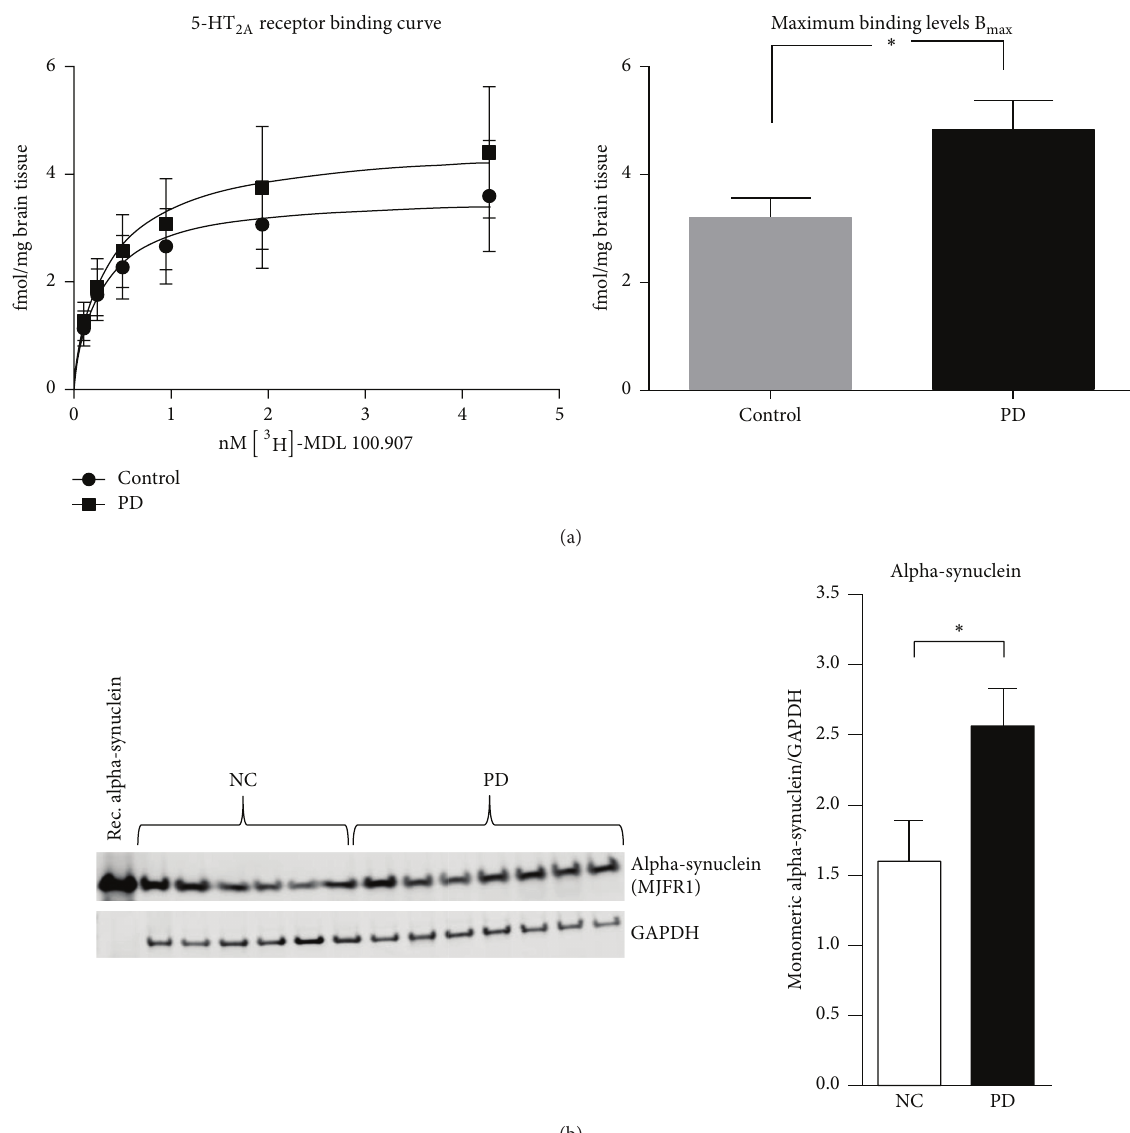
Figure 1: Receptor binding analysis and alpha-synuclein levels in postmortem prefrontal cortex of Parkinson’s disease (PD) patients. (a) Binding assays with [ 3 H] MDL100.907 comparing membrane suspensions from postmortem prefrontal cortex of Parkinson’s disease (PD) patients and controls show higher maximum binding levels ( 𝐵 max ) of the 5 -HT 2 A receptor in the PD group. (b) Western blot showing higher levels of alpha-synuclein proteins in the PD brains included in the binding assay. Control = normal controls; PD = Parkinson’s disease patients. Significant ∗ 𝑝 < 0.05 . Student’s 𝑡 - test with mean ±